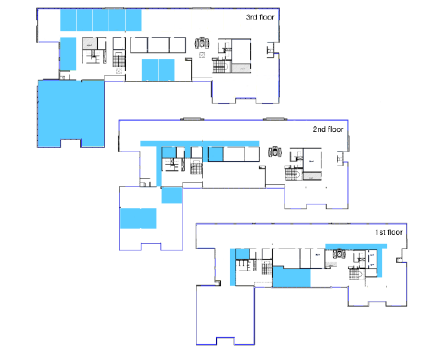
Figure 5. Topology of the deployment on FIT IoT-LAB Lille’s site (https://www.iot-lab.info/lille-new- physical-topology-released.).